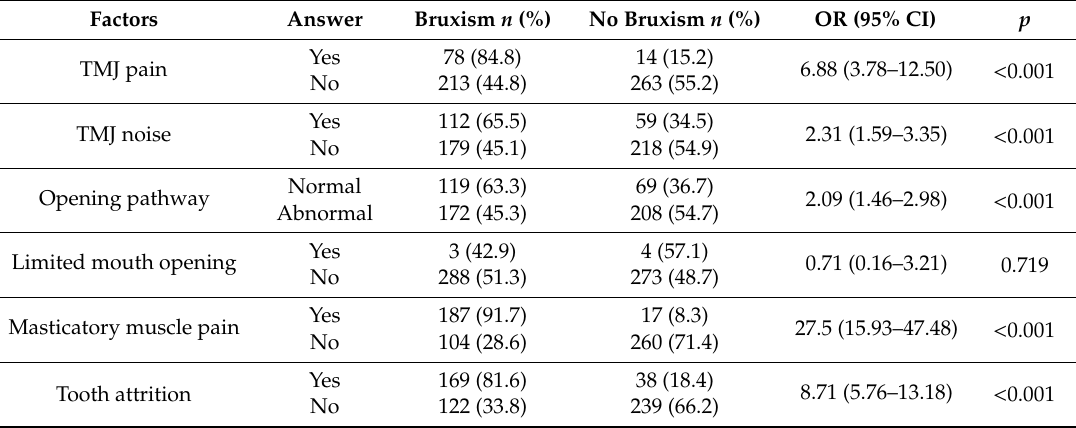
Table 3. Relations between the presence of bruxism and associated